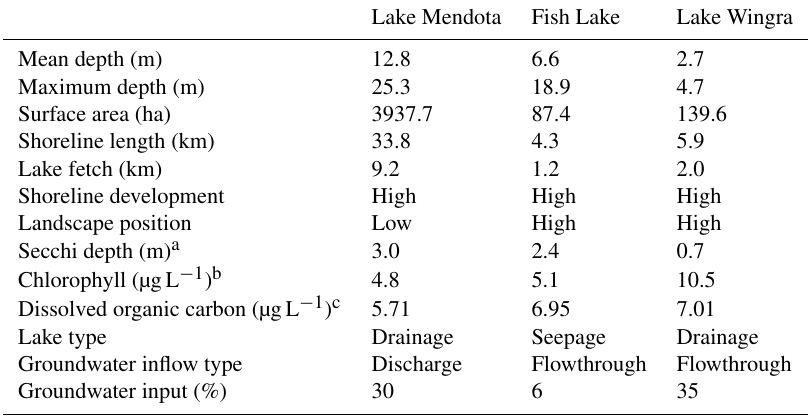
Table 1. Lake characteristics for the three study